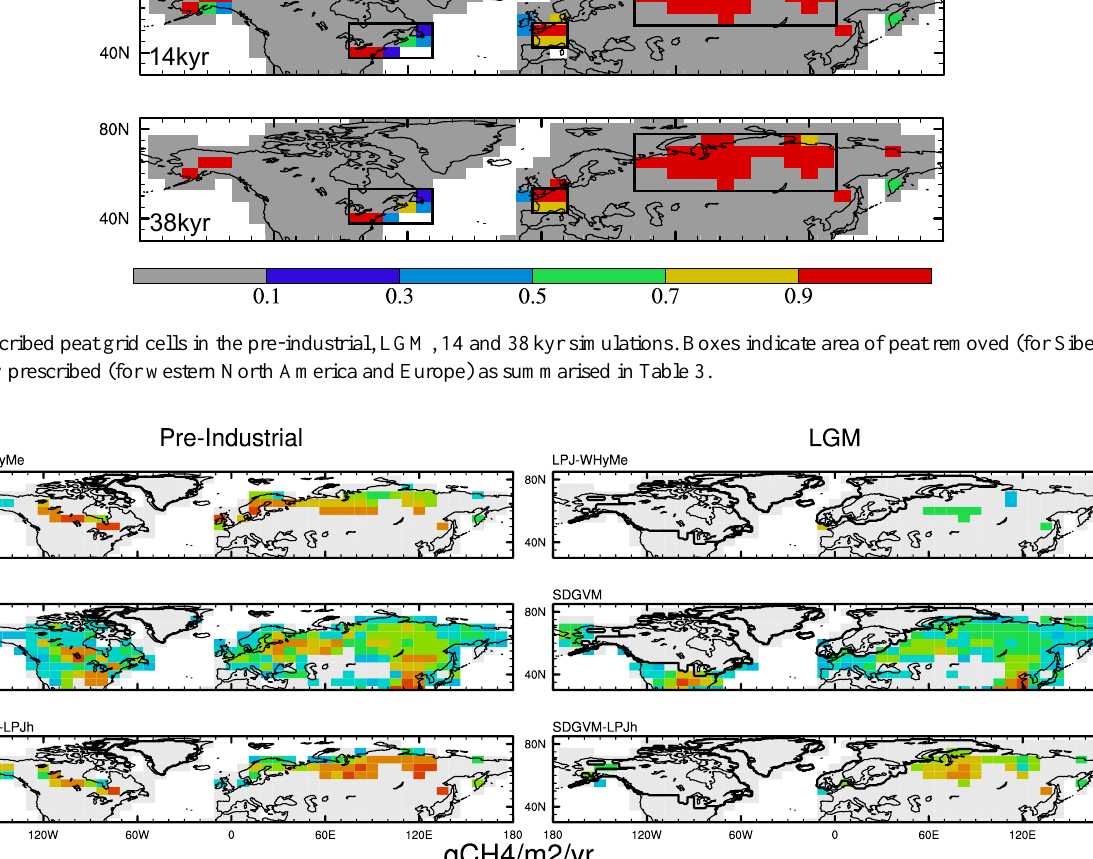
comparison section. We also see the dominant influence of the abrupt warming on thaw depth, but this is not the case for the water table depth, which appears to respond on a slower response time, with the very slight deepening of the water ta- ble depth during the abrupt cooling persisting until after the abrupt warming has